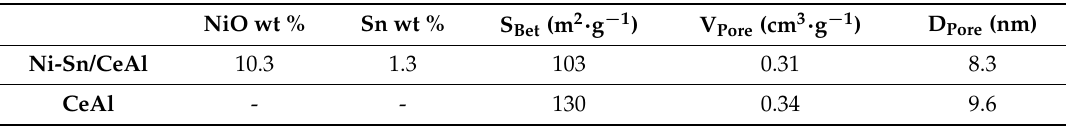
Table 2. Textural properties of Ni-Sn/CeAl post calcination as determined by the Brunauer–Emmett–Teller (BET) equation and X-ray fluorescence (XRF) analysis.